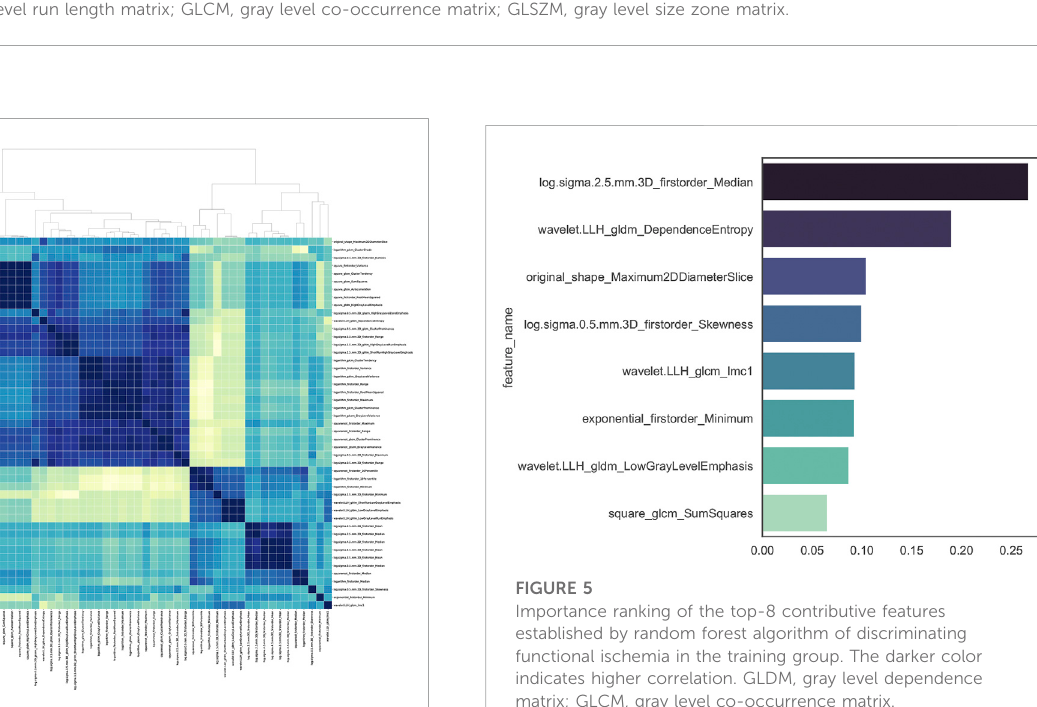
FIGURE 4 Correlation heatmap and dendrogram derived from hierarchical clustering in the training group. Boruta algorithm identi fi ed 8 different clusters derived from 47 important features. The darker color indicates higher correlation coef fi cient. GLDM, gray level dependence matrix; GLCM, gray level co- occurrence matrix; GLSZM, gray level size zone matrix; GLRLM, gray level run length matrix.